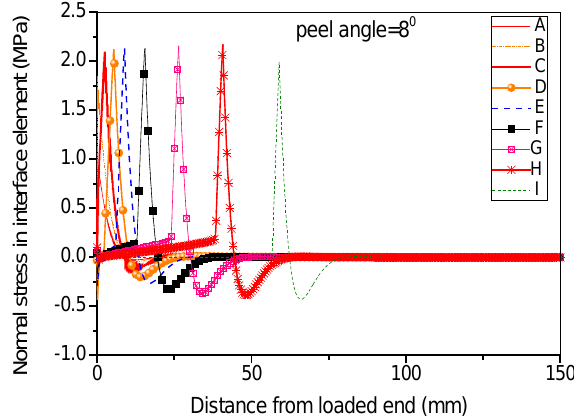
Figure 21. Normal stress distribution along the interface at different load levels when the peel angle = 8 degree.